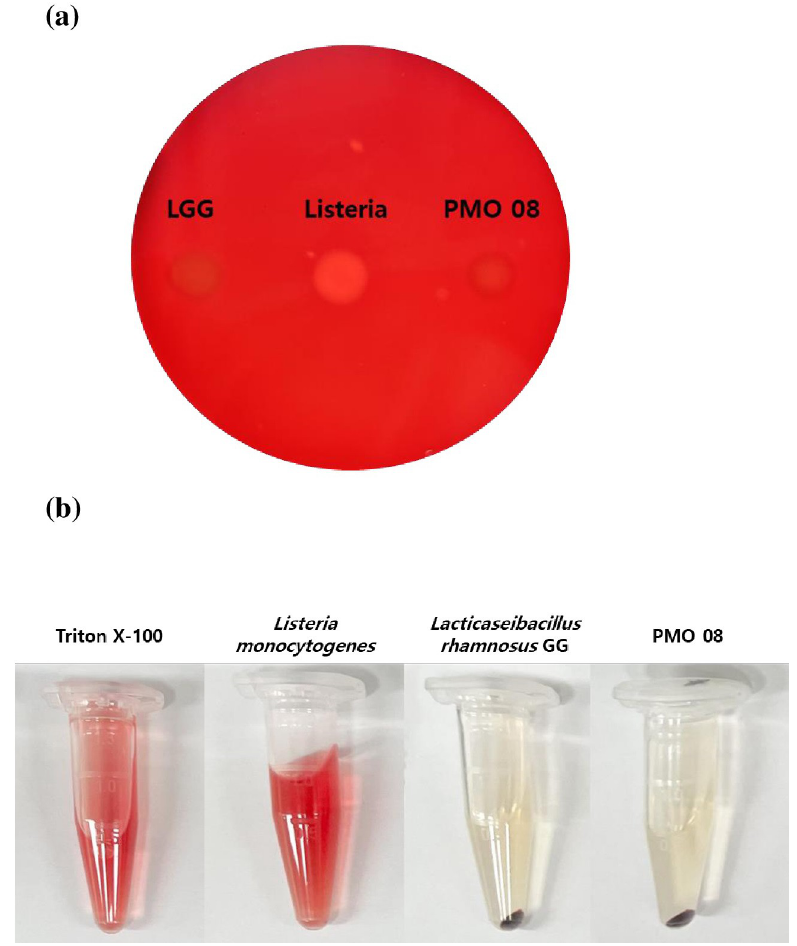
Fig 3. Hemolysin activity of Lactiplantibacillus plantarum PMO 08 on erythrocytes. (a) Hemolysin activity of Lp . plantarum PMO 08 analyzed on a 5% sheep blood agar plate. (b) Hemolysin activity of culture supernatant from Lp . plantarum PMO 08 treated with erythrocytes. Triton X-100 and Listeria monocytogenes used as a positive control and Lp . rhamnosus GG used as a negative